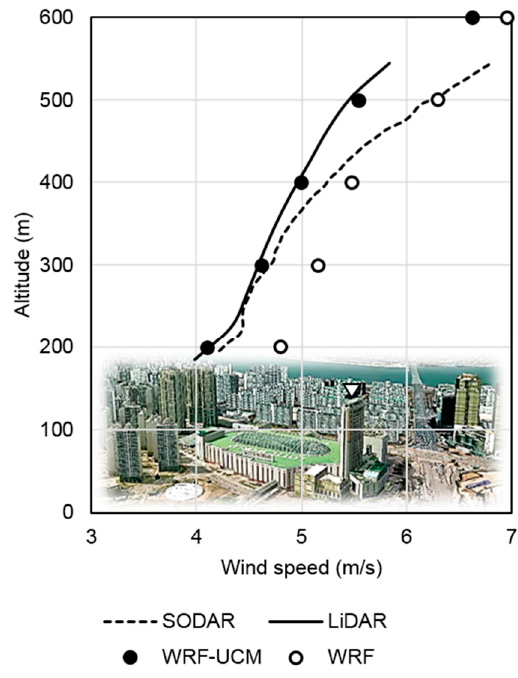
Figure 11. Comparison of wind speed profiles of remote sensing measurements (LIDAR and SODAR: lines) and numerical weather predictions (WRF and WRF–UCM: symbols).